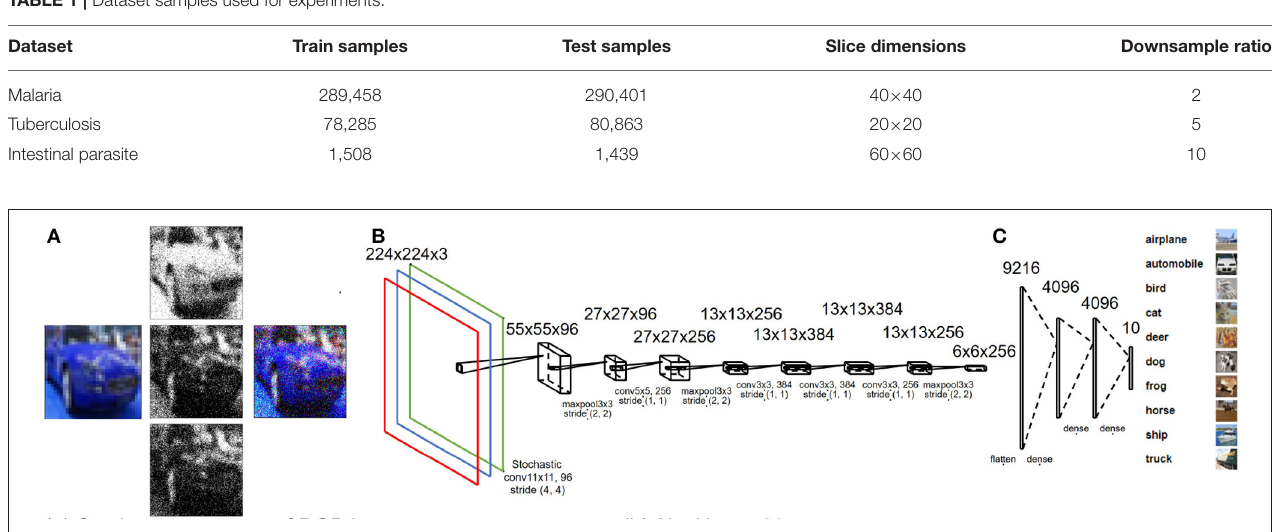
Here, X r , i denotes the normalized response, X d , i denotes the actual input, and i denotes the color channel. The dataflow is shown in Figure 2 . This type of rescaling is often used to enhance the accuracy of deep neural